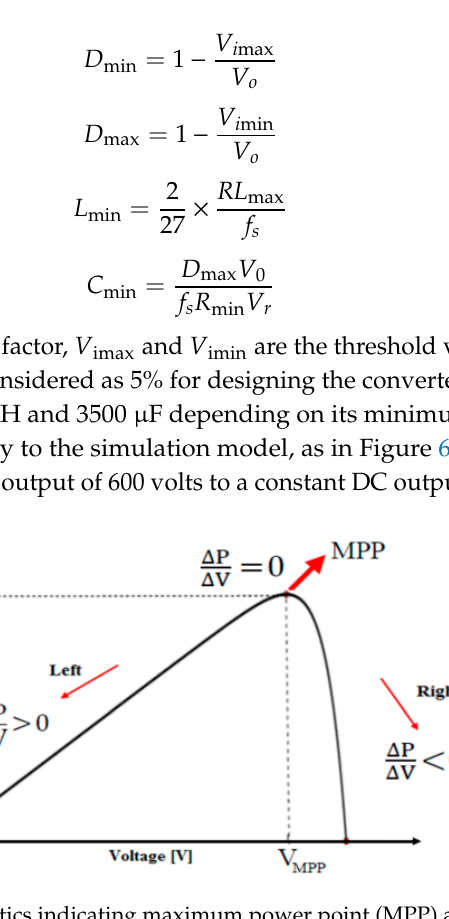
Figure 6. Solar panel characteristics indicating maximum power point (MPP) and operating principle.